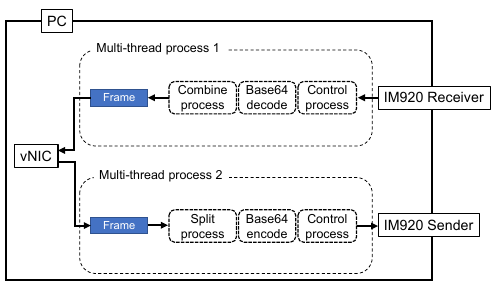
Figure 5. Internal processes on a PC for the implementation of the communication bridge using IM920.